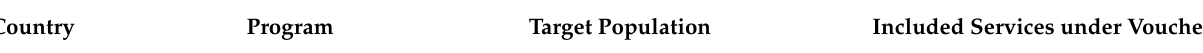
Table 1. Summary of included studies for sub-Saharan